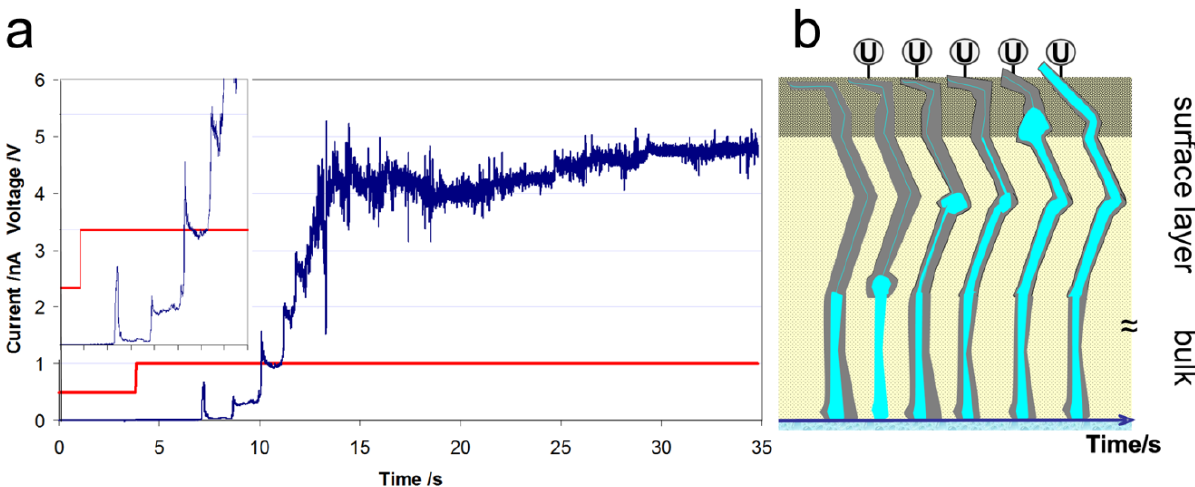
Figure 5. ( a ) Dependence of current with time after a voltage step from 0.5 to 1.0 V. In the inset, the onset region for the step-wise increase in the current is visible. The level of the pseudo-steady-state current is increased after each subsequent step. ( b ) Scheme of the stepwise widening of current/water channels under water pressure due to electro-osmotic drag of water by protonic current according to the visco-elastic properties of Nafion ®